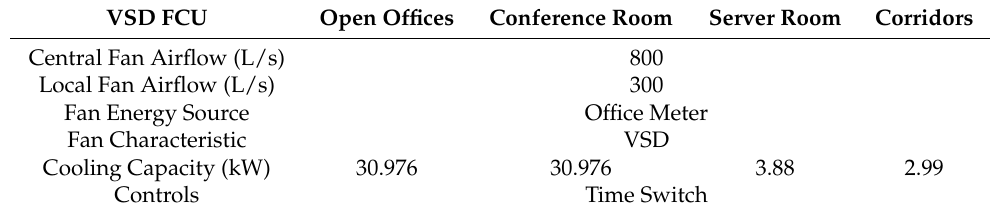
Table 9. Design variables for FCU with Variable Speed Drive (VSD).